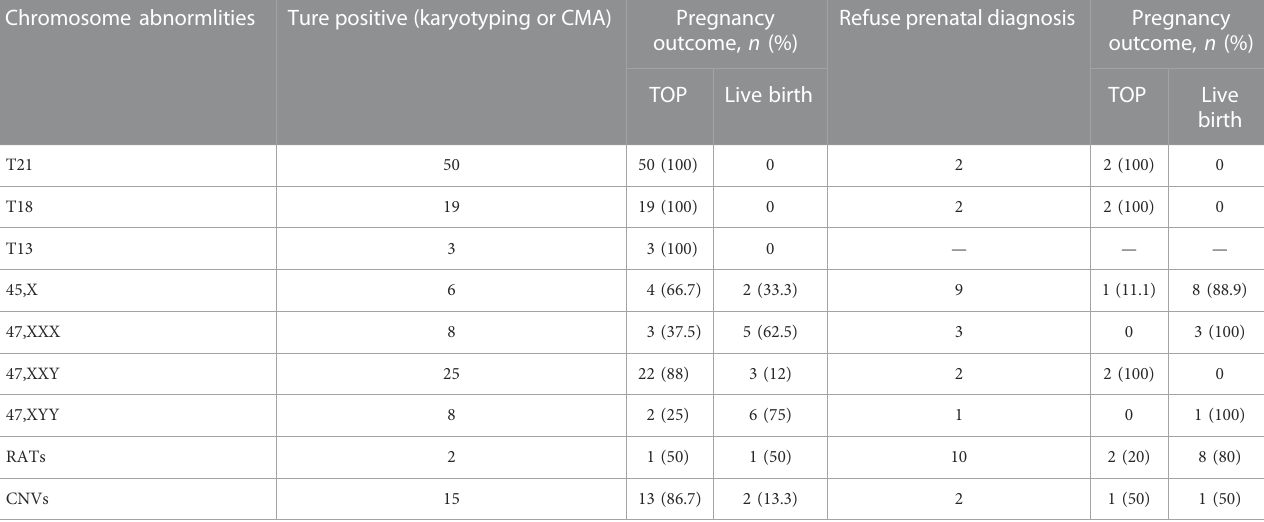
signi fi cant difference between the two groups in PPV for T18, T13, SCAs, RATs, and CNVs (T18 58.33% vs. 54.55%, T13 25.00% vs. 22.22%, SCAs 70.37% vs 66.67%, RTAs 16.67% vs. 4.17%, CNVs